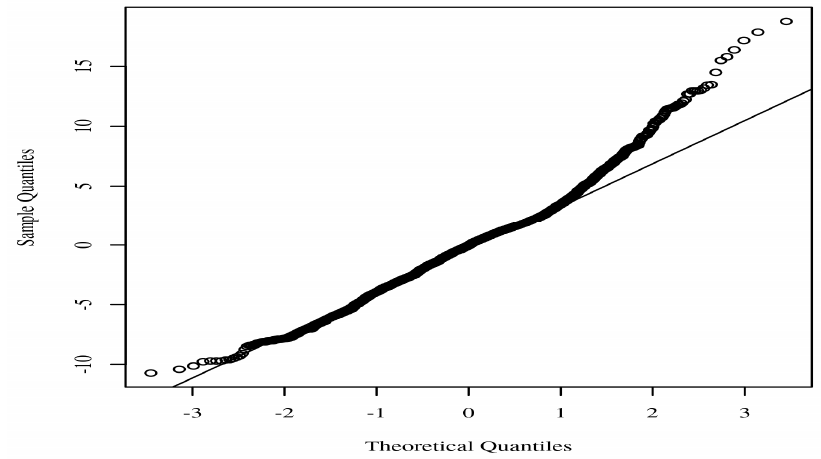
Figure 1. Regression model Q-Q scatterplot for residual normality.